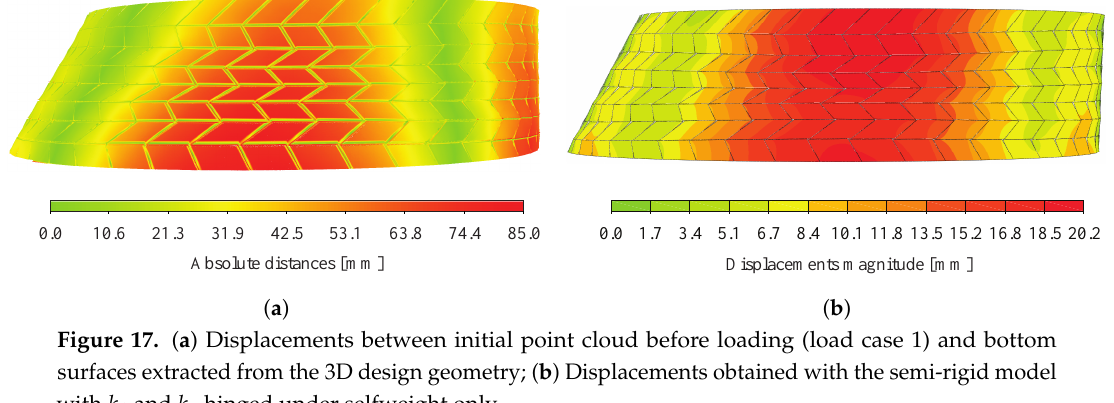
Figure 17. ( a ) Displacements between initial point cloud before loading (load case 1) and bottom surfaces extracted from the 3D design geometry; ( b ) Displacements obtained with the semi-rigid model with k 4 and k 6 hinged under selfweight